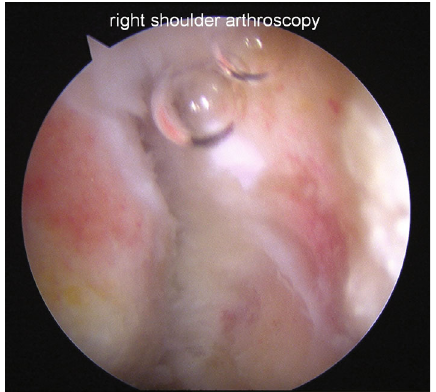
Figure 3: Arthroscopic image of the fi nal position following fi xation.